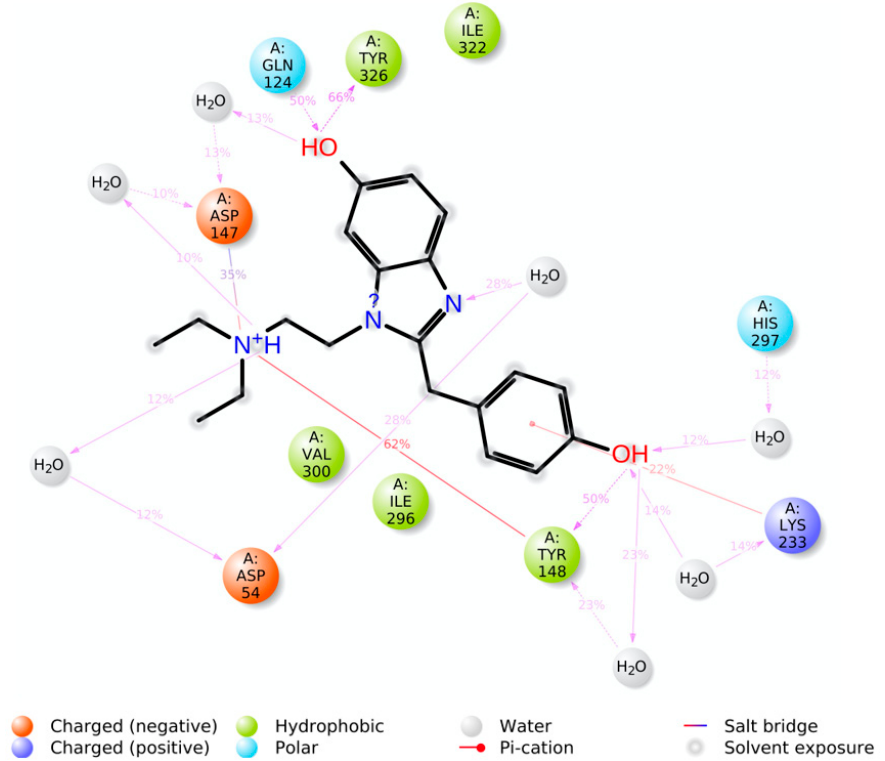
Figure 10. A two-dimensional interaction diagram of the detailed MOR ‒ M6 complex atom interac- tions with key protein residues during the 200-ns MD simulation.